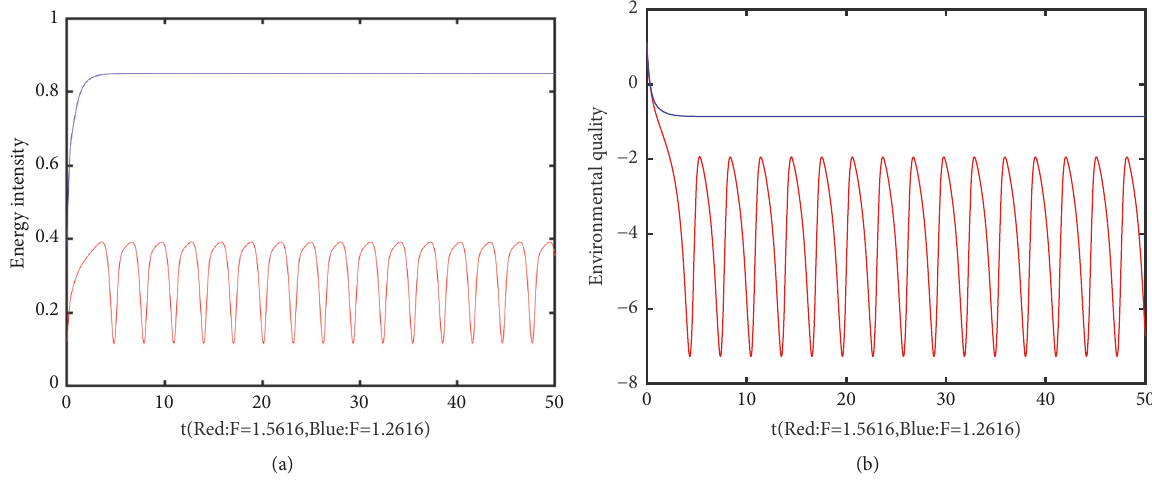
Figure 9: The influenceof system (1) parameters 𝐹 on energy intensity and environmentalquality: (a) energy intensity and (b) environmental quality.